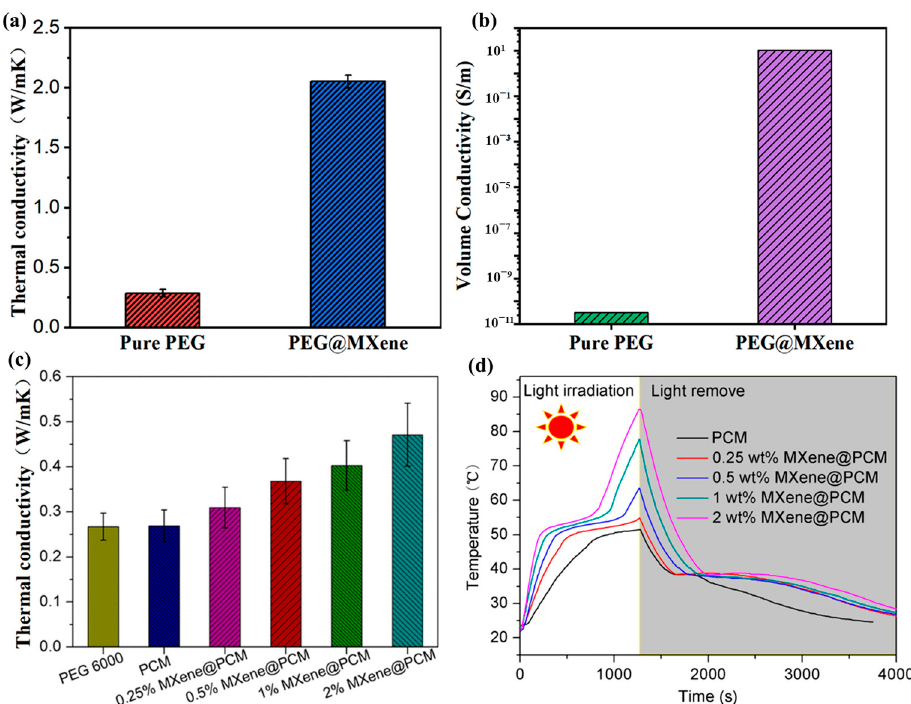
Figure 10. ( a,b ) Thermal and electrical conductivity of pristine PEG and fabricated PEG@MXene [111], ( c ) Thermal conductivities of PEG 6000, PCM, and MXene@PCMs, ( d ) Temperature evolution curves of the PCM and MXene@PCMs [106].